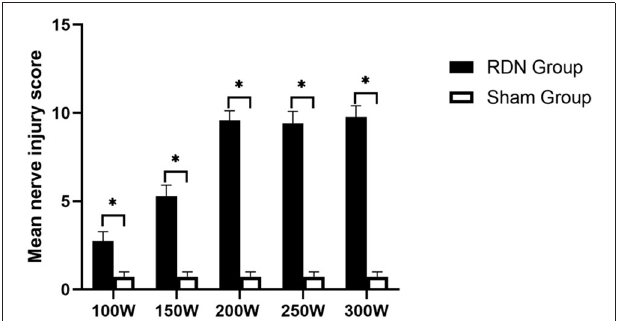
FIGURE 4 | Semiquantitative histological assessment of periarterial nerves at day 28; * <